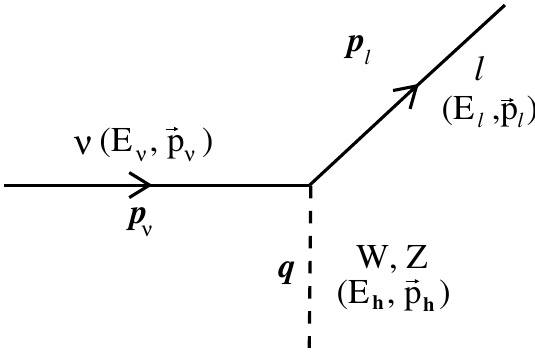
Figure 1 . Sketch illustrating the de(cid:12)nition of hadronic energy and momentum ( E h ; ~p h ) used in this paper as the four-momentum transfer q between the incoming neutrino ( E (cid:23) ; ~p (cid:23) ) and the outgoing lepton ( E ‘ ; ~p ‘ ) in a neutrino